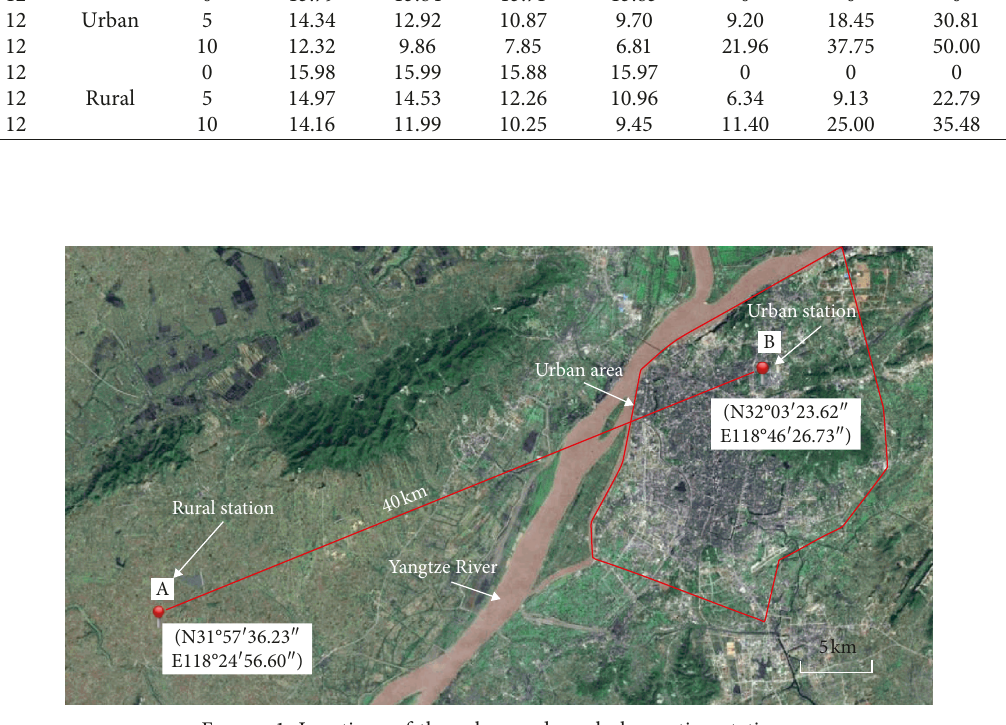
Figure 1: Locations of the urban and rural observation